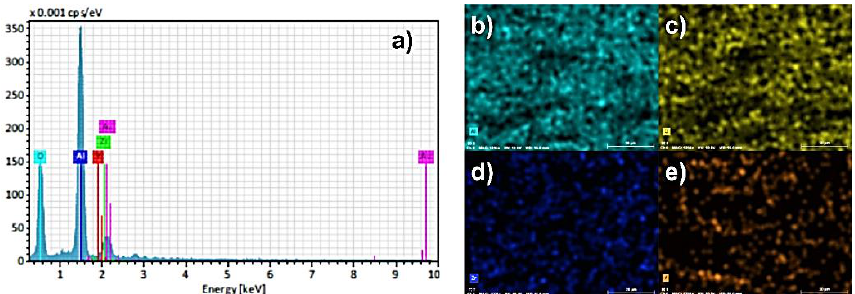
Figure 10. ( a ) EDS spectra of surface fracture of Al 2 O 3 –ZrO 2 ceramics with 5 wt. % of ZrO 2 and corresponding element mappings: ( b ) Aluminum (Al); ( c ) Oxygen (O); ( d ) Zirconium (Zr); ( e ) Yttrium (Y).